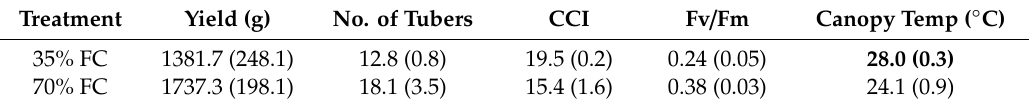
Table 1. Agronomic and physiological traits averaged for drought (35% field capacity) and control (70% field capacity) plots with standard error of the mean in parentheses. Bold numbers indicate significance ( p < 0.05) between